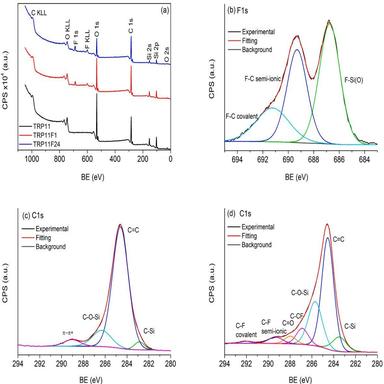
(a) Survey XPS spectra of TRP11, TRP11F1 and TRP11F24 samples. High resolution XPS spectra (b) of F1s for TRP11F24, (c) of C1s for TRP11 and (d) of C1s for TRP11F24, respectively.